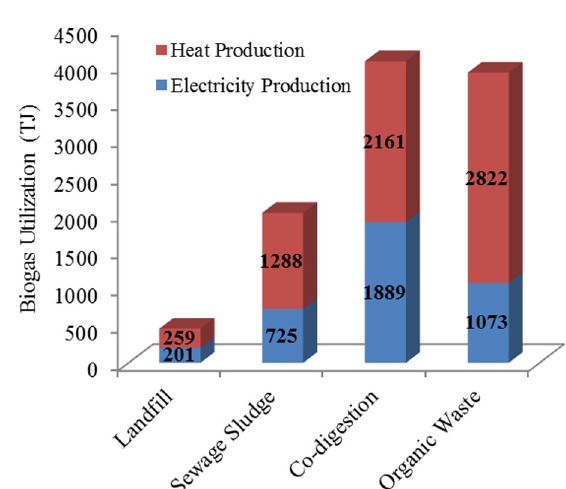
Fig. 1. Utilization of biogas in the Netherlands, 2014. Adapted from